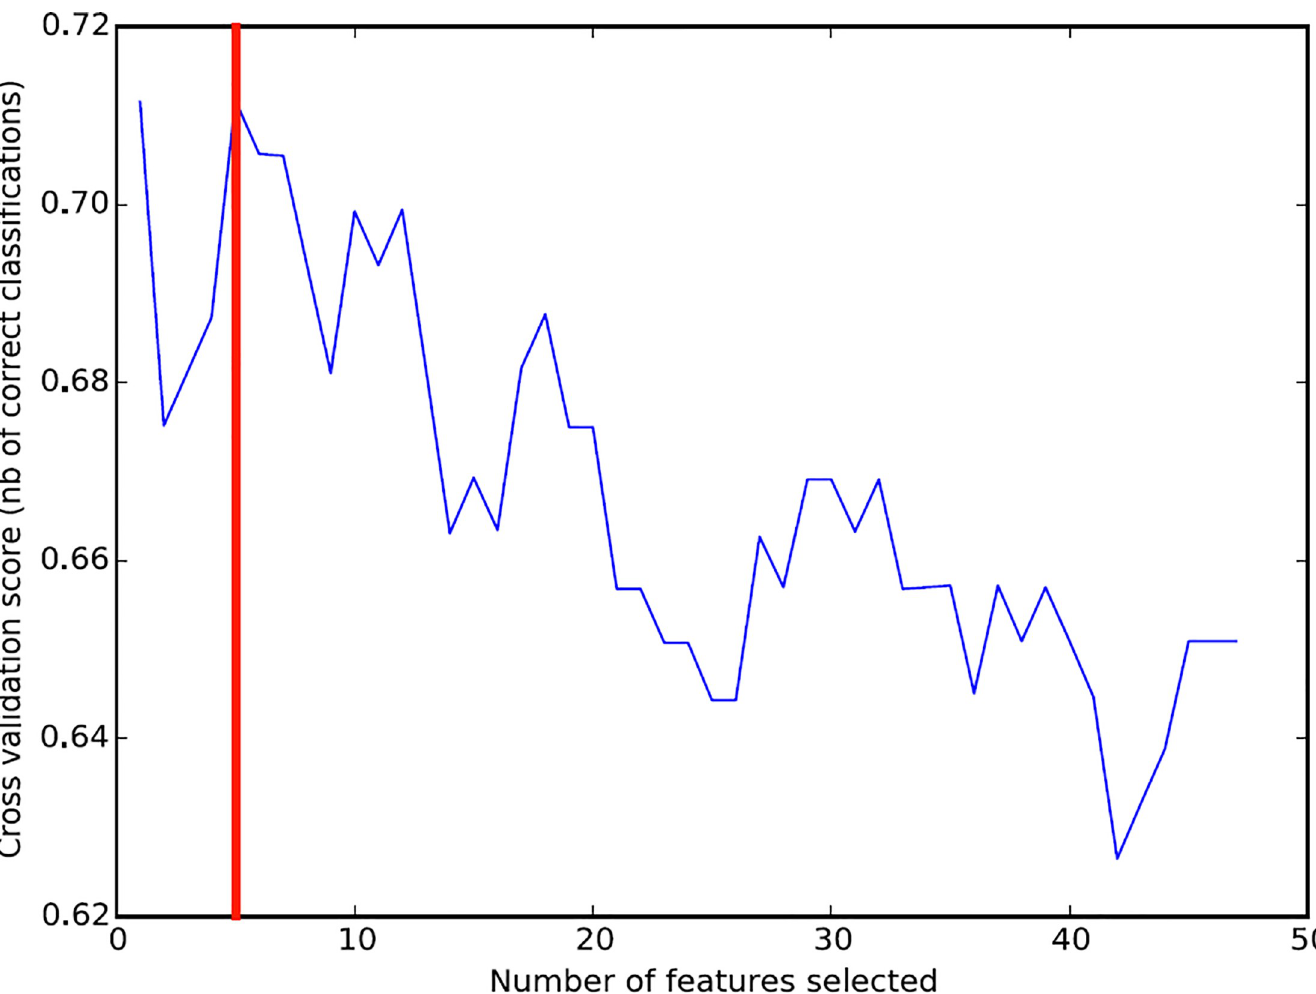
Fig 5. Feature recursive optimization. The horizontal axis is the number of feature selections, and the vertical axis is the prediction accuracy of cross-validation.